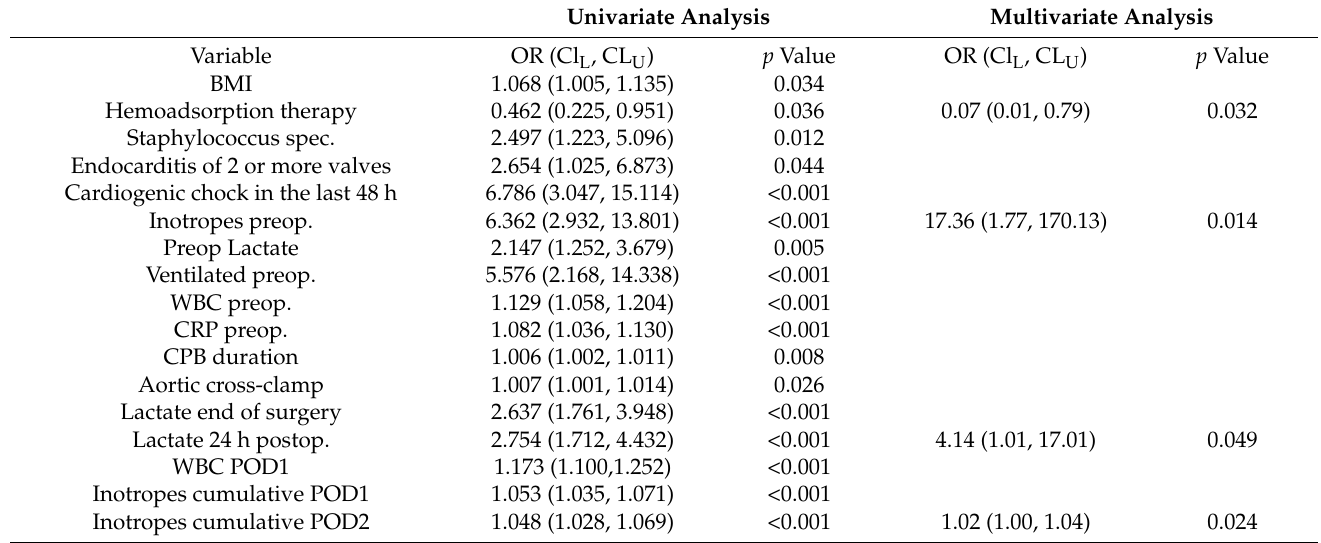
Table 6. Variables related to in-hospital